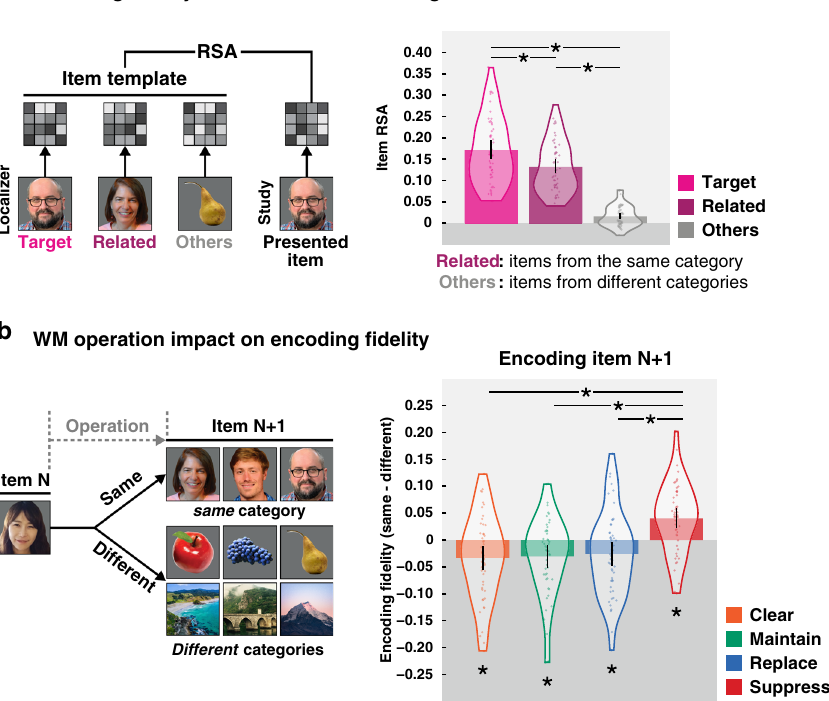
Fig. 5 Impact of cognitive operations in WM on fi delity of subsequent encoding. a (Left) Item-speci fi c patterns of brain activity were used as templates for comparison with each item presented during the central study. (right) The RSA data con fi rm that this analysis was sensitive enough to identify the presented (target) item on each trial. There was a signi fi cantly higher similarity when between the target template from the localizer task and the presented item in the central study, than with either items from the same category (related) or items from different categories (others). * P < 0.05, two- sided, repeated measures pair-wise T -tests (Tukey – Kramer corrected). Across pairwise comparisons, P s < 1.11e − 16. b Each image was sorted based on the preceding item and operation. Bar graphs on the right re fl ect the encoding fi delity on the N + 1 trial of same-category images vs. different-category images (used as a baseline) following each operation type. Values below zero indicate proactive interference for encoding same-category images. The only operation that did not lead to proactive interference was suppress, suggesting that only it is effective in expunging the item on the prior ( N ) trial from working memory. * P < 0.05, two-sided, repeated measures pair-wise T -tests (Tukey – Kramer corrected). Across the signi fi cant comparisons, P s < 0.001. Violin plots show the full distribution of n = 50 participants with dots corresponding to individual participants. Error bars indicate 95% CI. See Supplementary Table 4 for full statistics. Source data are provided as a Source Data fi